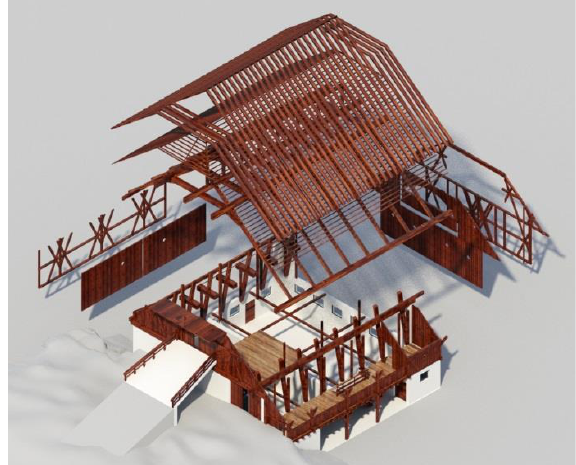
Figure 5: Exploded axonometric view of the construction system of the Aschnerhof